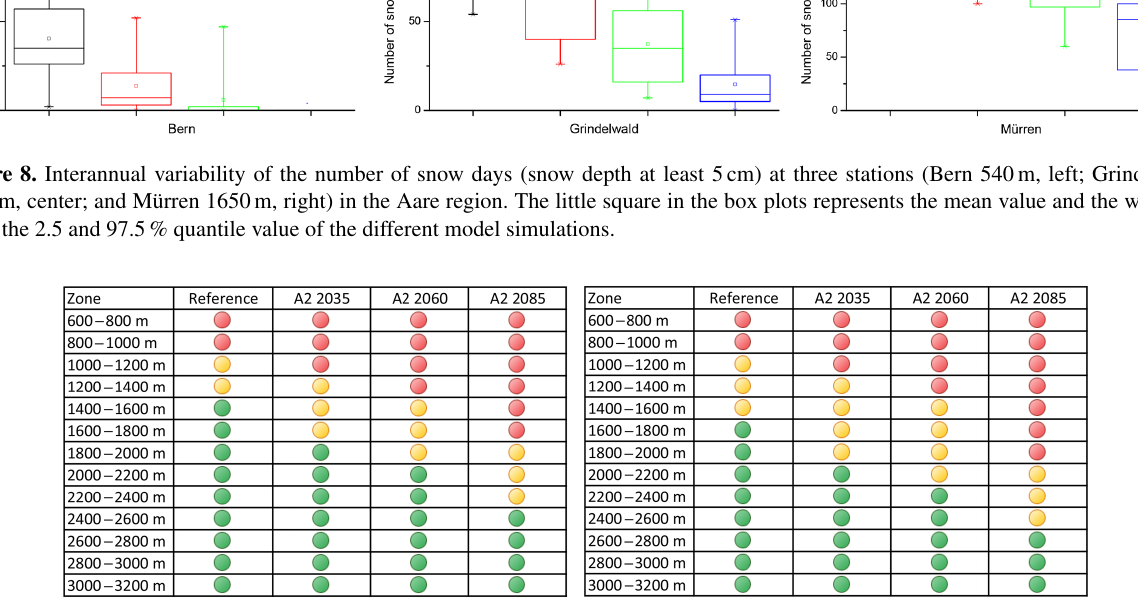
Figure 9. Assessment of the elevation-dependent natural snow reliability in the Aare region for north-facing (left) and south-facing (right) aspects. Red: occurrence of snow not reliable – a minimum snow depth of 30cm was reached over less than 40 days. Green: snow reliable – at least 100 days with more than 30cm snow depth. Yellow: the cases between the green and red